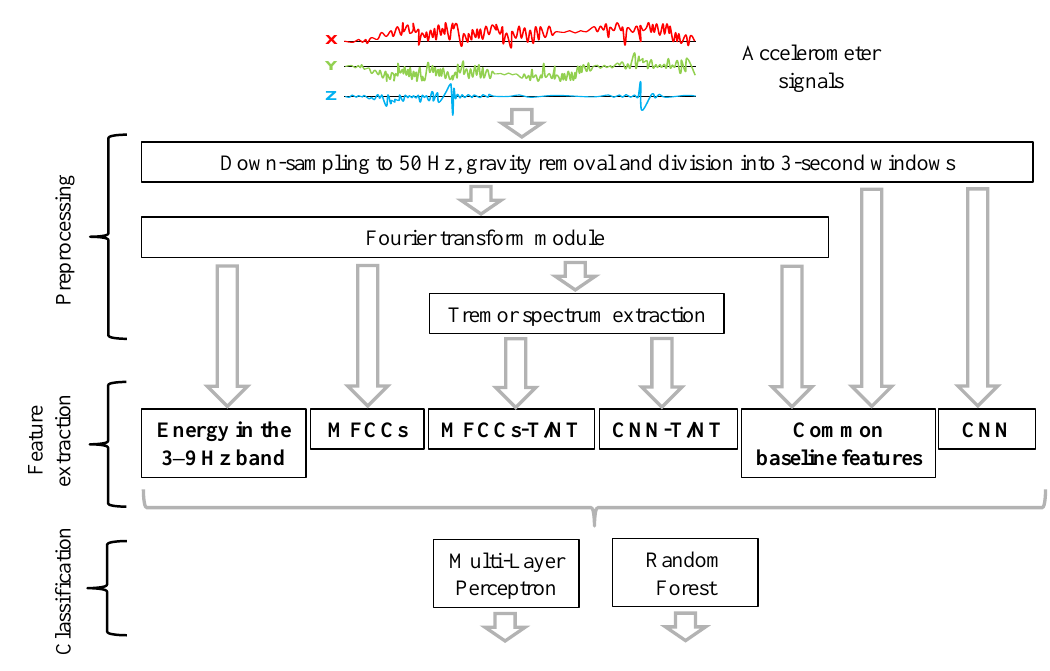
Figure 2. Diagram of the computation